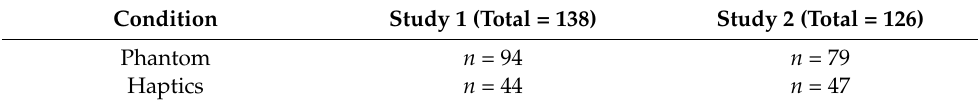
Table 1. The number of participants in the Phantom and Haptic Conditions for Study 1 and 2. Condition